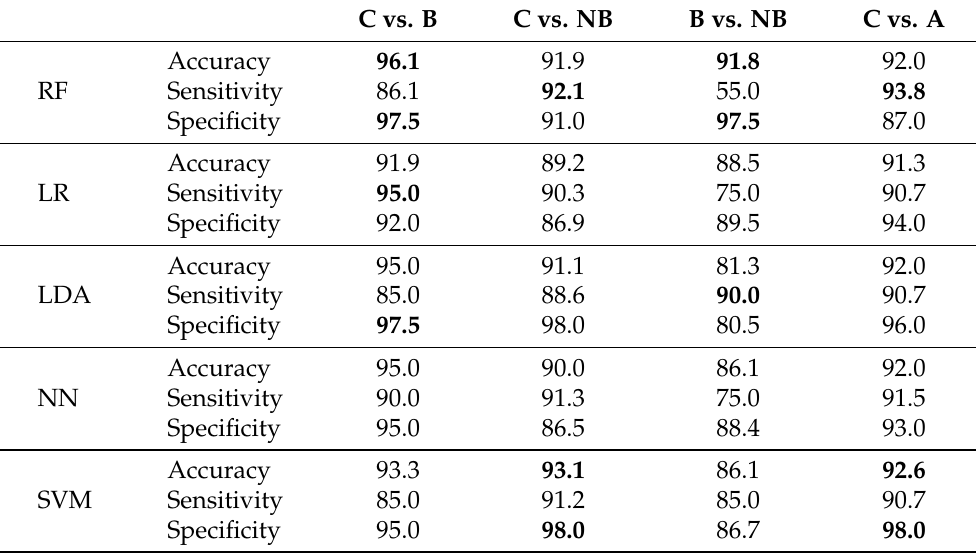
Table 4. Performance of male models. RF: Random Forest; LR: Logistic Regression; LDA: Linear Discriminant Analysis; NN: Neuronal Networks; SVM: Support Vector